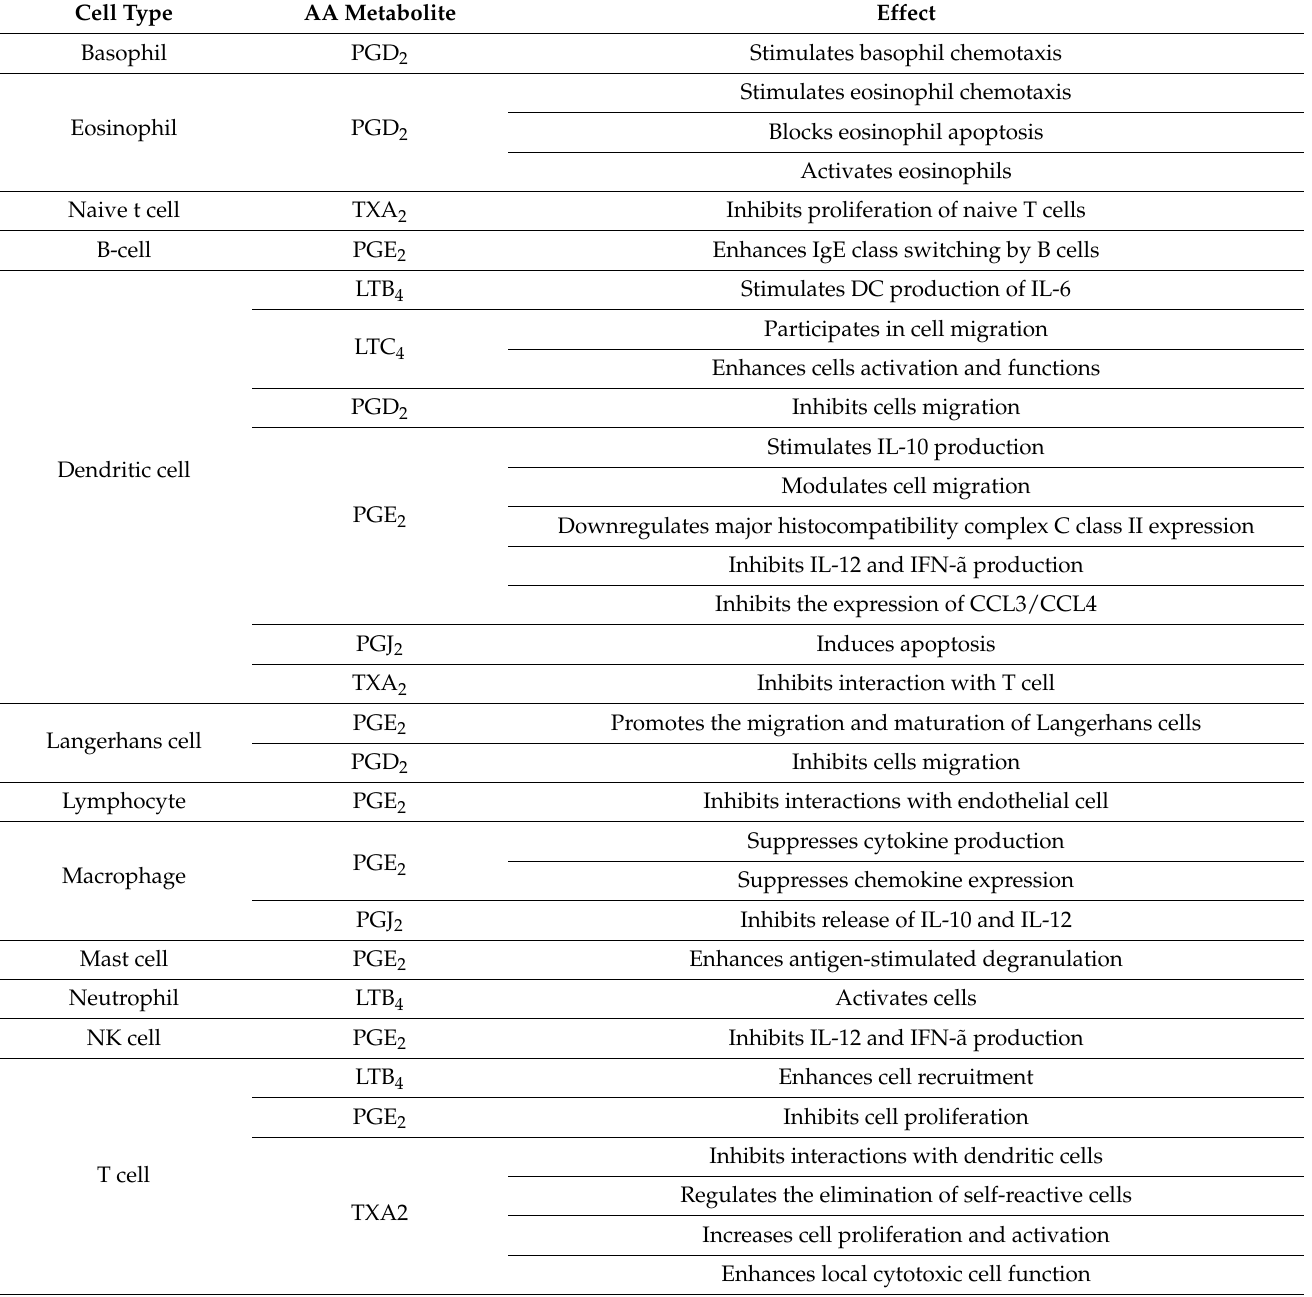
Table 2. Effects of AA metabolites on immune cells [38]; AA metabolites affect immune cells in various ways, modulating the immune response and